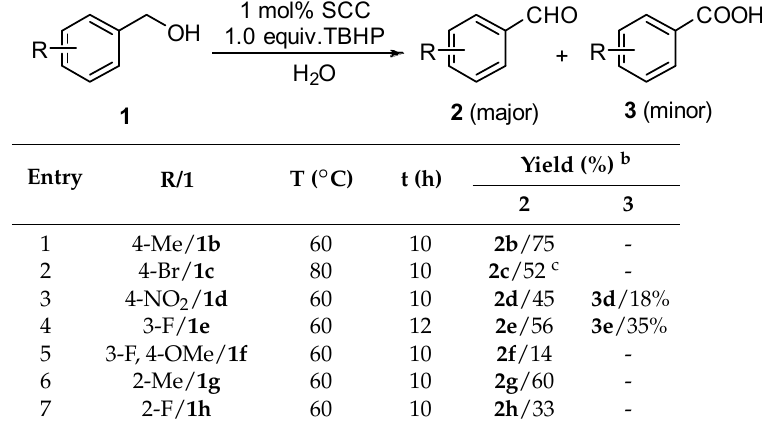
Table 2. The oxidation of benzyl alcohol catalyzed by sodium copper chlorophyllin (SCC) a . CHO OH